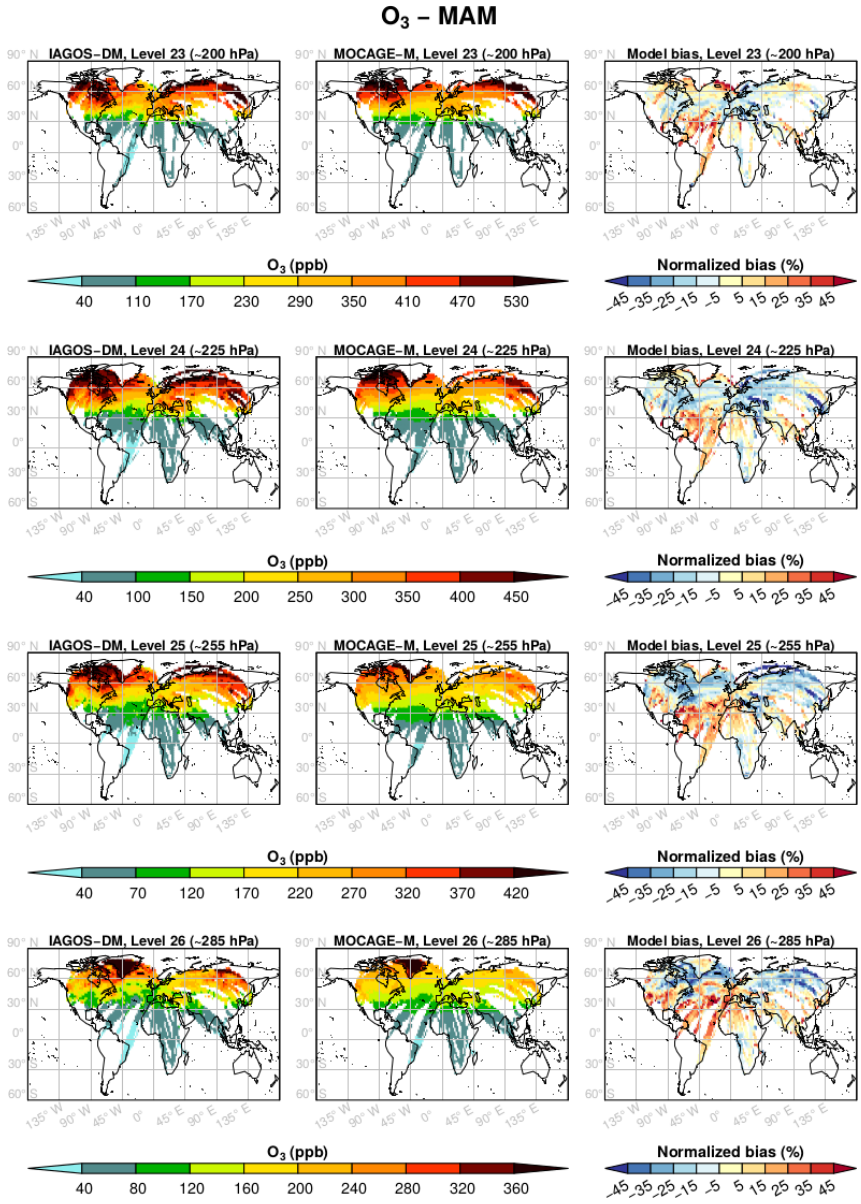
Figure A2. As Fig. 3 for boreal